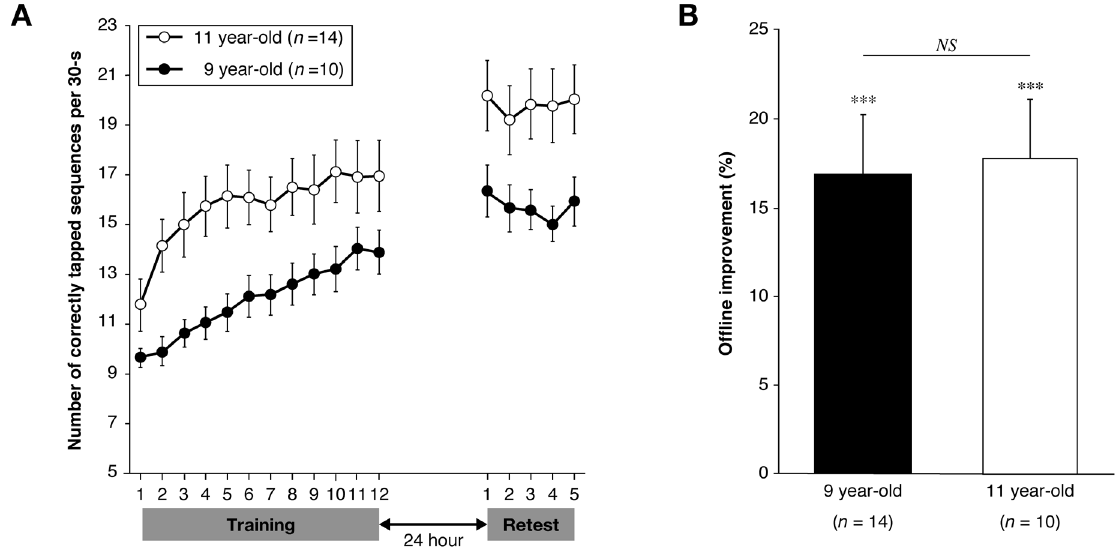
Figure 1. Motor sequence performance and improvement between days in the two different age groups. ( A ) Participants in both groups showed significant offline improvement, measured by the performance improvement between the last three trials during training on day 1 and the first three trials during retest on day 2 ( p values , 0.001). The black circles represent the mean performance during each trial in the 9-year-old group, and the open circles represent the mean performance in the 11-year-old group. ( B ) In total, performance in the 11-year-old children was significantly better than that in the 9-year-old children ( p , 0.05). However, the degree of offline improvement did not differ between the age groups (two-tailed unpaired t-test; p =0.51). The black bar represents the 9-year-old group and the white bar represents the 11-year-old group. Error bars indicate the standard error of the mean (SEM). *** p , 0.001; ** p , 0.01 (repeated-measures ANOVA).